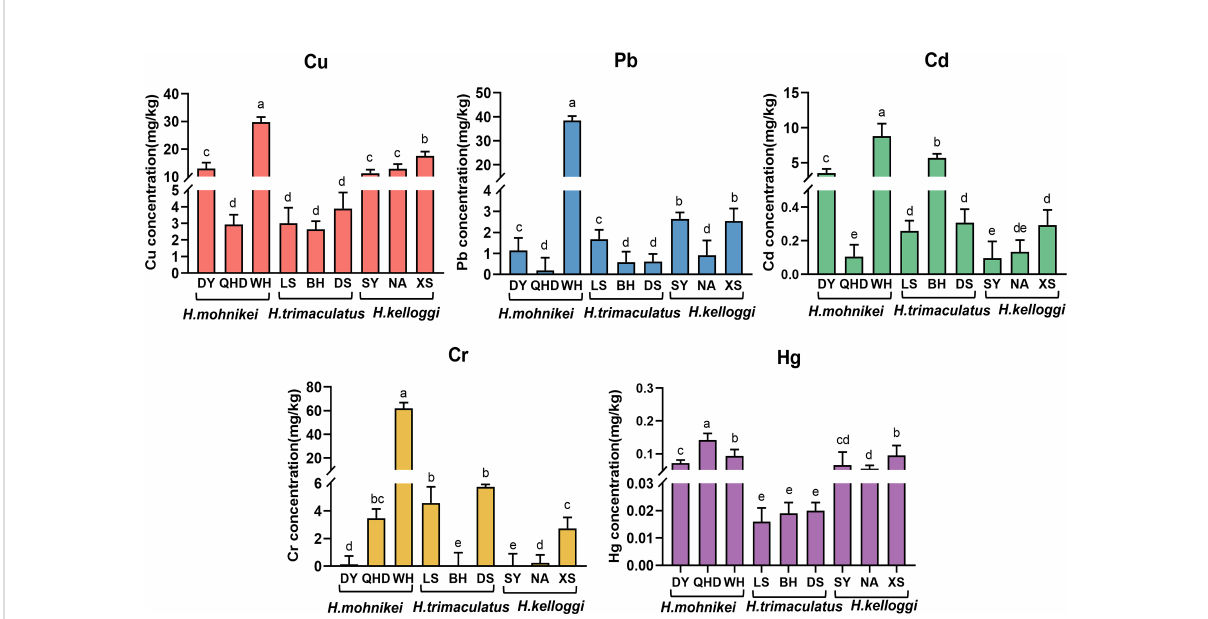
FIGURE 2 Sampling locations along the China coast (Dongying, Qinghuangdao, Weihai, Lingshui, Beihai, Dongshan, Sanya, Nanao, Xiangshan). Different colors represent different heavy metals. Letters indicate signi fi cant difference( P <